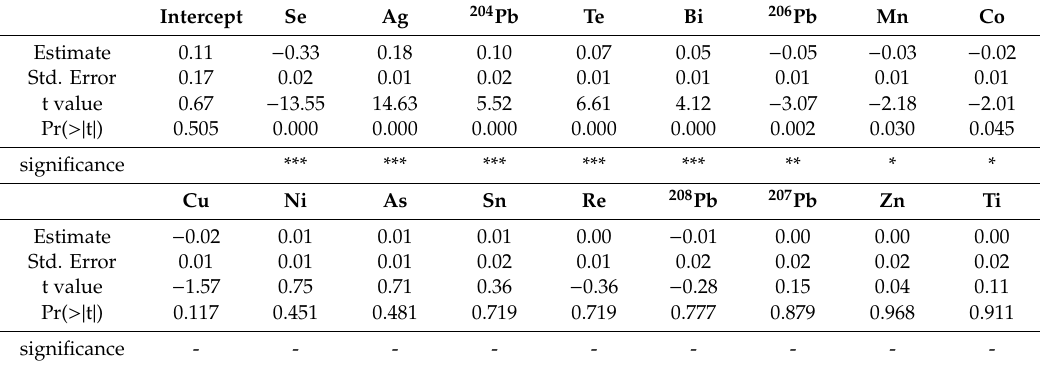
Table 5. Results from robust multiple regression of the log(Au) for the ilr-coordinates of the remaining 17 elements in N = 1501 dataset. The extended results of classic and robust regressions fitted to the three datasets are in Supplementary Material